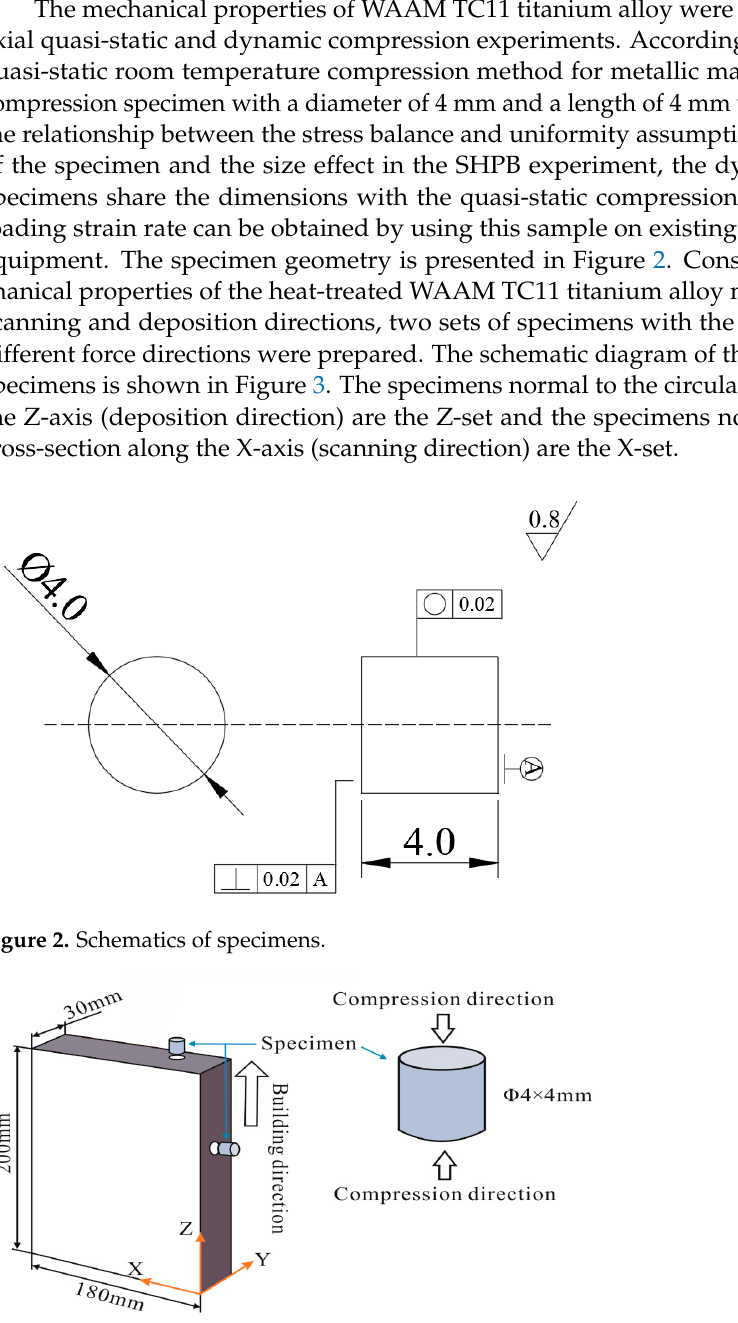
Figure 3. Schematic diagram of the sampling method for specimens.